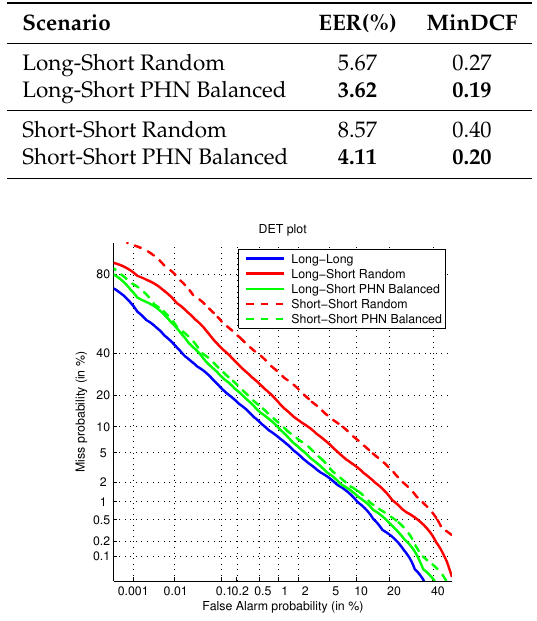
Figure 5. Detection Error Trade-off (DET) curves for the scenarios Long-Long (blue), Long-Short and Short-Short Random (red continuous and dashed line respective), Long-Short and Short-Short Balanced (green continuous and dashed line respective) for SRE10 “coreext-coreext det5 female”